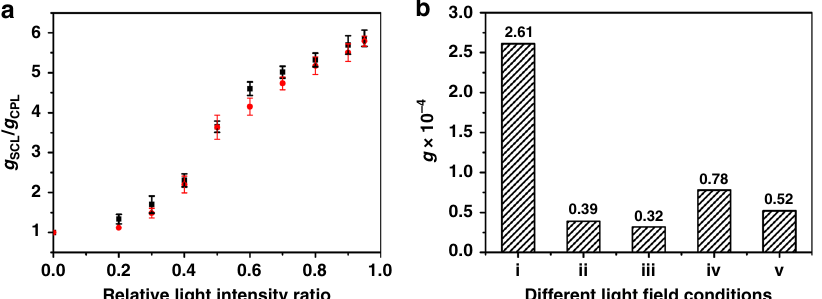
Fig. 4 Dissymmetry enhancement mechanism. a The relative enhancement factor, g CSL / g CPL for fi nal PDA fi lms as a function of the relative light intensity ratio, R , by application of left-handed (black dots) or right-handed SCL(red dots). At least four irradiation experiments were performed to obtain the average g -value, and error bars represented standard deviations of measured g values. b The g value at 577 nm for fi nal PDA fi lms upon irradiation with two counter-propagating CPL beams with (i) opposite or (ii) same handedness; two CPL beams propagated along the same direction with (iii) opposite or (iv) same handedness; or (v) one CPL beam (4.0 mW cm − 2 ),